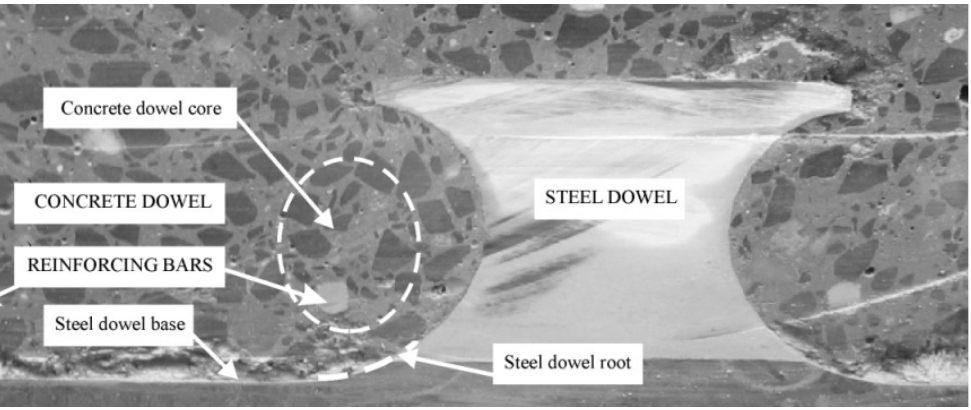
Figure 31: General view of the CL shape tested in the PreCo-Beam project [7] with a height of 100 mm and spacing between dowels equal to 300 mm (specific nomenclature used for composite dowels is